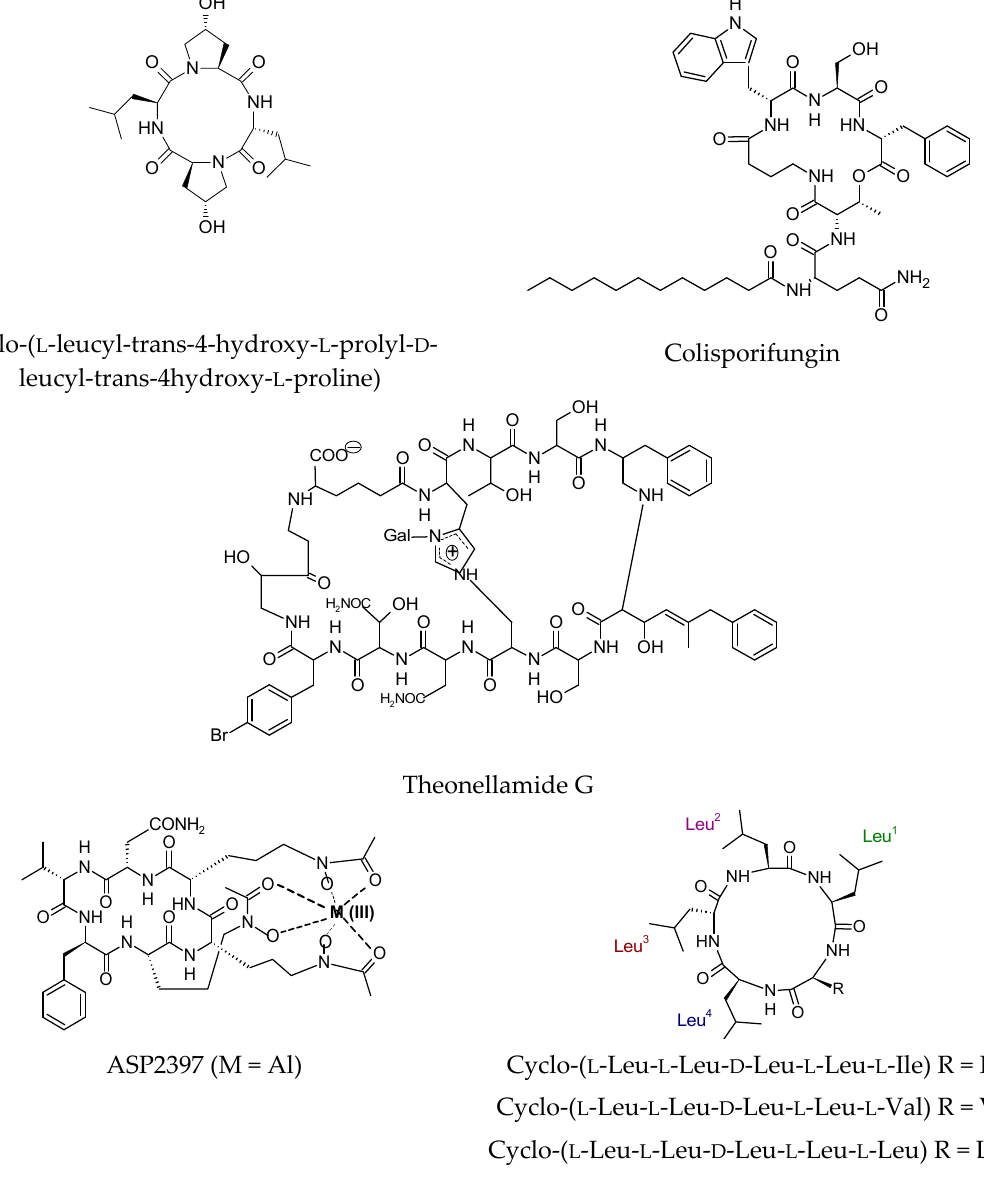
Figure 3. Recently isolated antifungal cyclic peptides.